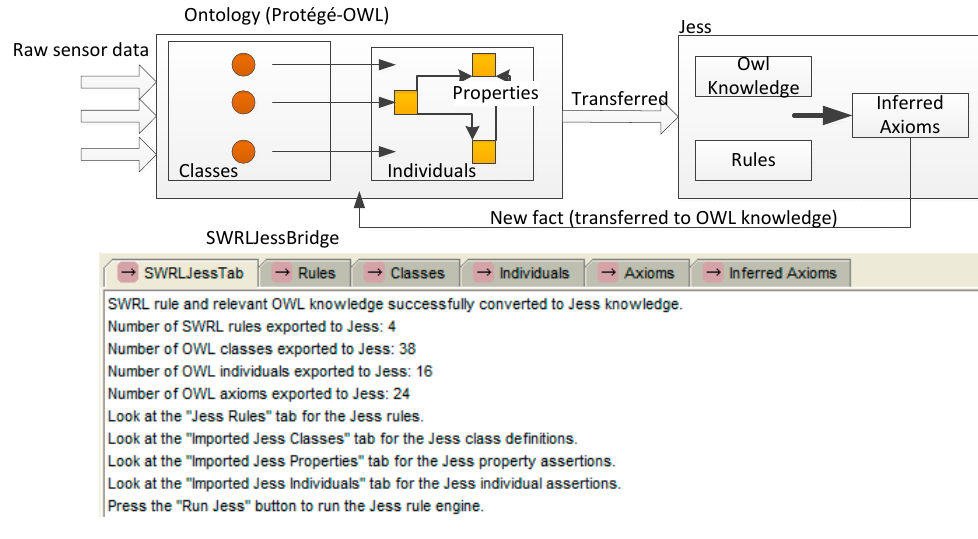
Figure 9. Reasoning process with the help of Protege-OWL/Jess.